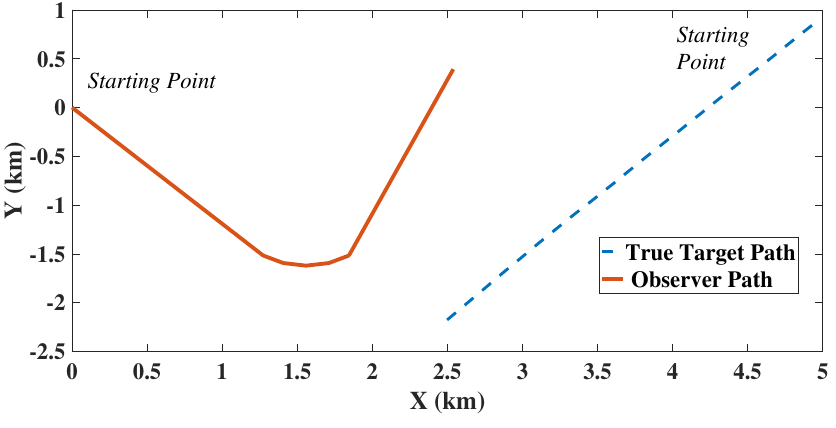
Figure 1. Target Observer Dynamics in 2D.